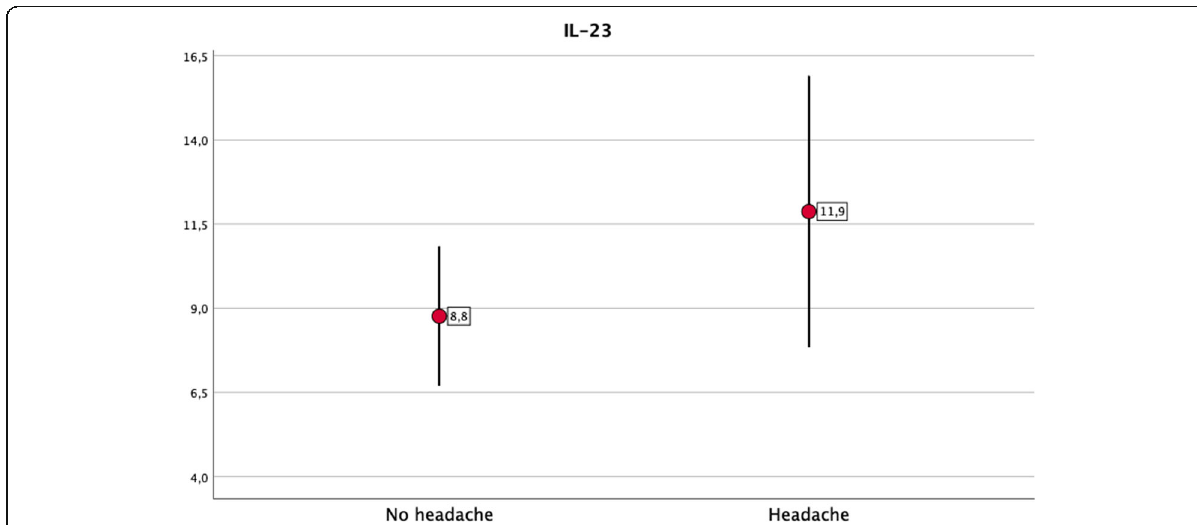
Fig. 2 Comparison of median IL-23 levels between COVID-19 patients with and without headache by ANCOVA test, adjusting for age, sex, baseline disability and COVID-19